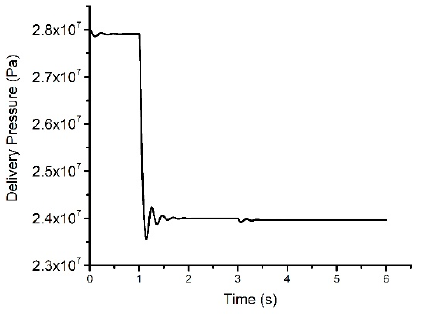
Figure 10. The delivery pressure of EHPAAPP with backstepping sliding control method in the case of input signal change from 28 MPa to 24 MPa with flow disturbance.